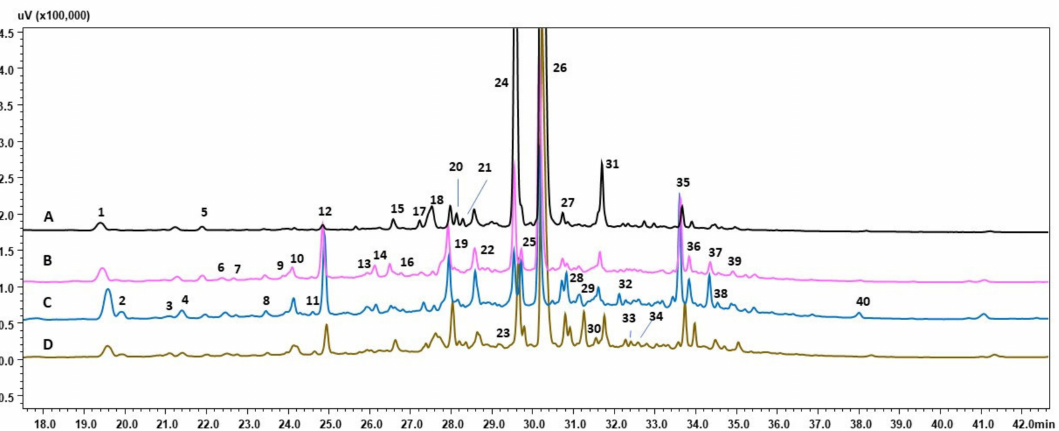
Figure 4. HPLC-PDA chromatograms (wavelength 320 nm) of RgTR17 line root extracts: (A) 28-day- old (time zero); (B) 14-day old untreated roots-control; (C) roots treated 14 days with drought stress; (D) roots treated 14 days with cold